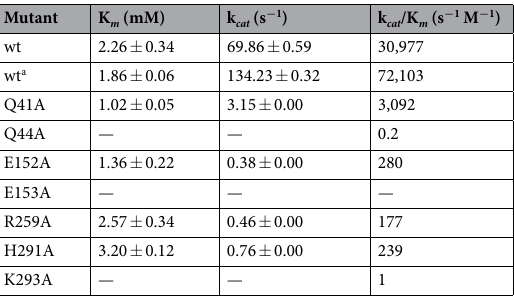
Table 3. Kinetic parameters for acceptor substrate Sia 2 Lac. Determined at constant donor concentration of 5 mM CMP-Neu5Ac. a Kinetic parameters for acceptor substrate Sia 3 Lac. Kinetic values are the mean ±